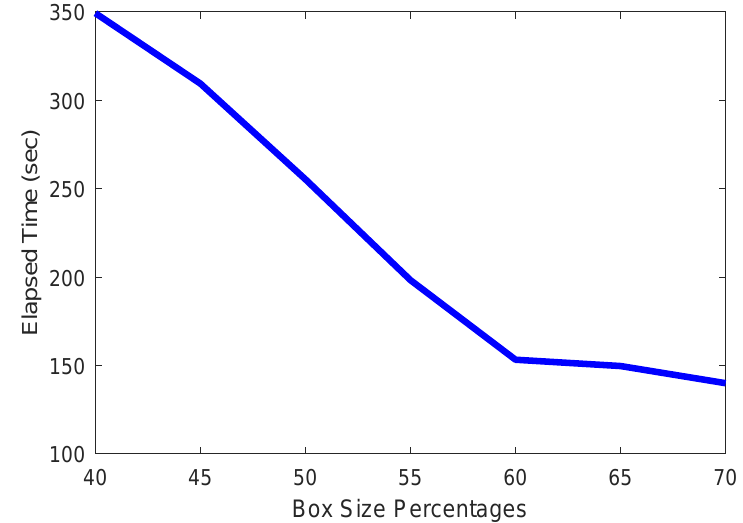
Figure 8. Plot of elapsed time vs. size of box.